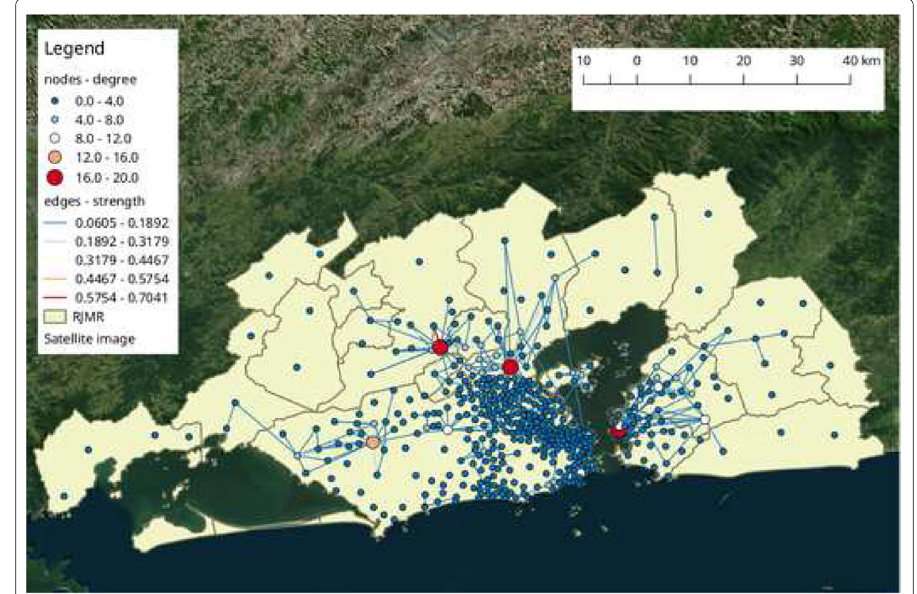
Fig. 7 Urban mobility geographical graph, (geo)graph, for the Metropolitan Region of Rio de Janeiro (highlighted area). Each node represents a traffic zone, and each edge corresponds to a flow intensity equal to or greater than the connection threshold (0.06). The element’s colors and size are proportional to the topological degree (for the nodes) and topological strength (for the